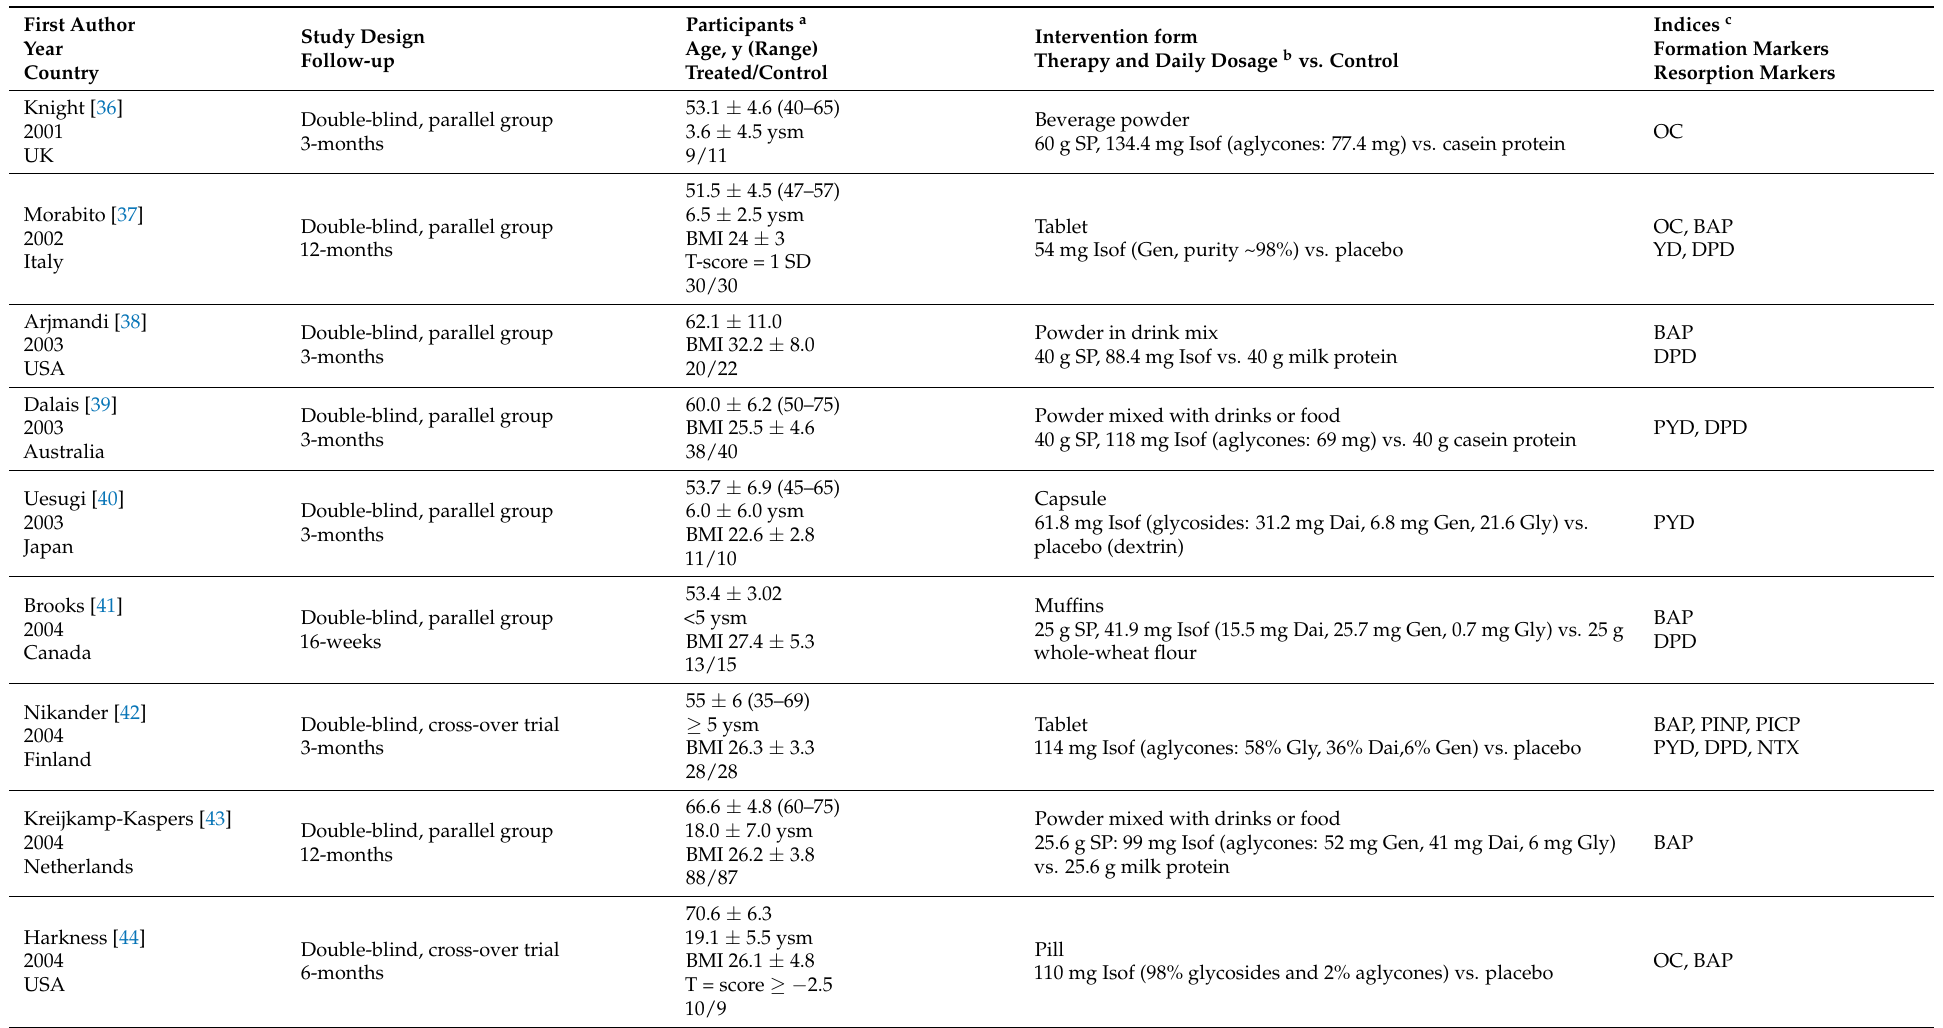
Table 1. Characteristics of selected randomized controlled studies assessing the effects of soy isoflavones on biochemical bone turnover markers in postmenopausal